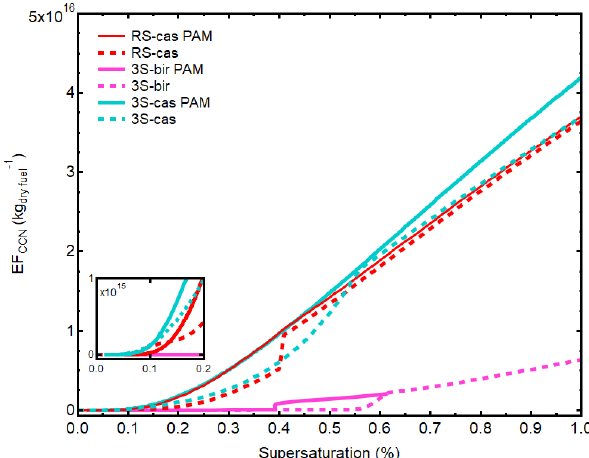
Figure 6. Examples of emission factors of CCN as estimated for the aerosol photochemically aged inside PAM with the unaged emission factors included for comparison. For the 3S-cas PAM experiment, the nucleation particle mode grew large enough to dominate near a mobility diameter of 65nm, which resulted in an increase in CCN for high